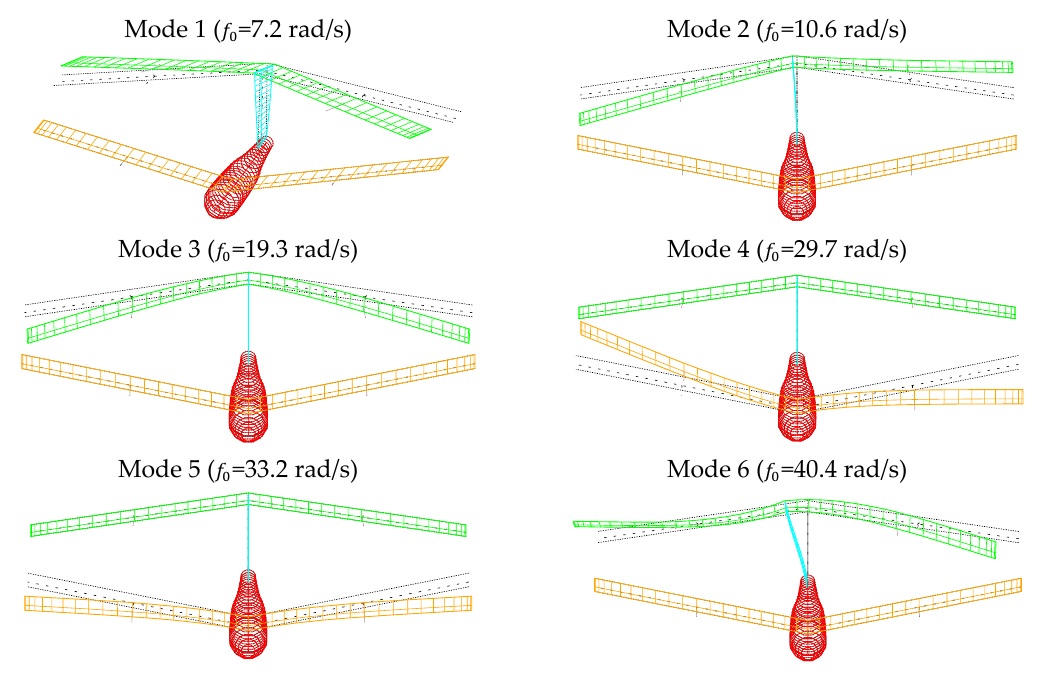
Figure 18. First natural frequencies and modes of the tandem-wing UAV with clamped fuselage.